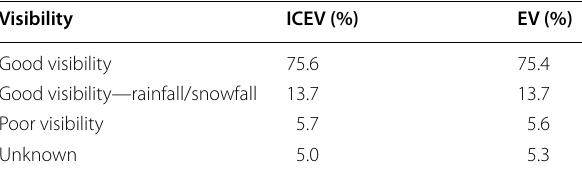
Table 5 Distributions of crashes by visibility